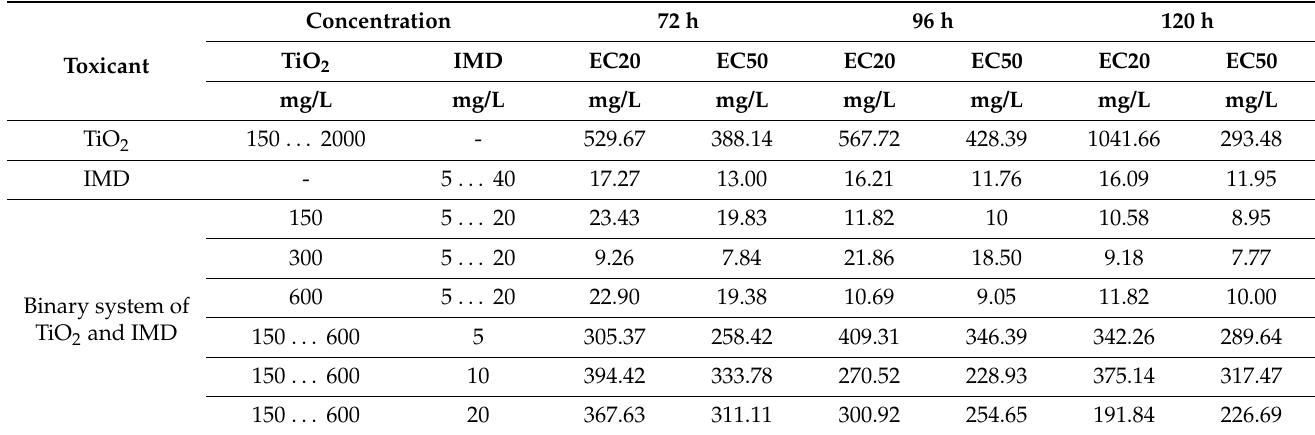
Table 2. The EC20 and EC50 for Chlorella vulgaris in terms of the single and binary response of TiO2 and IMD under 72, 96, and 120 h acute toxicity.